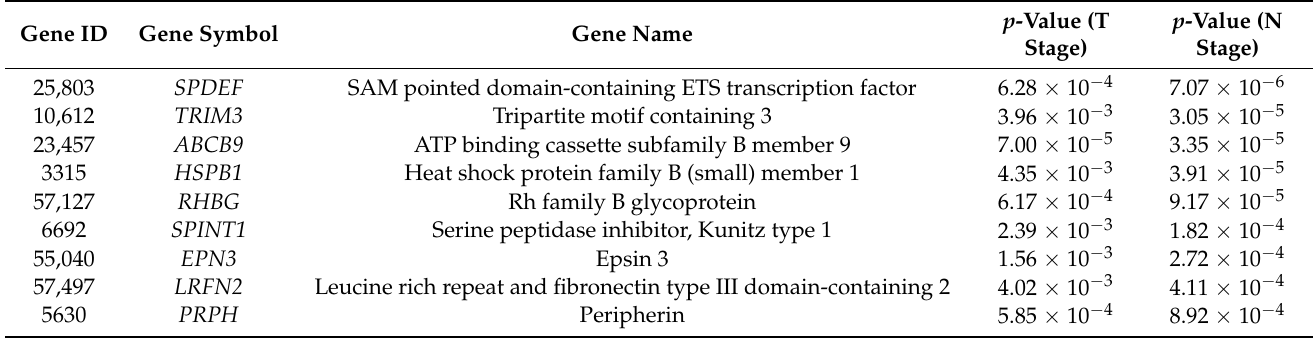
Table 1. Upregulated genes with overlapping expression in T and N